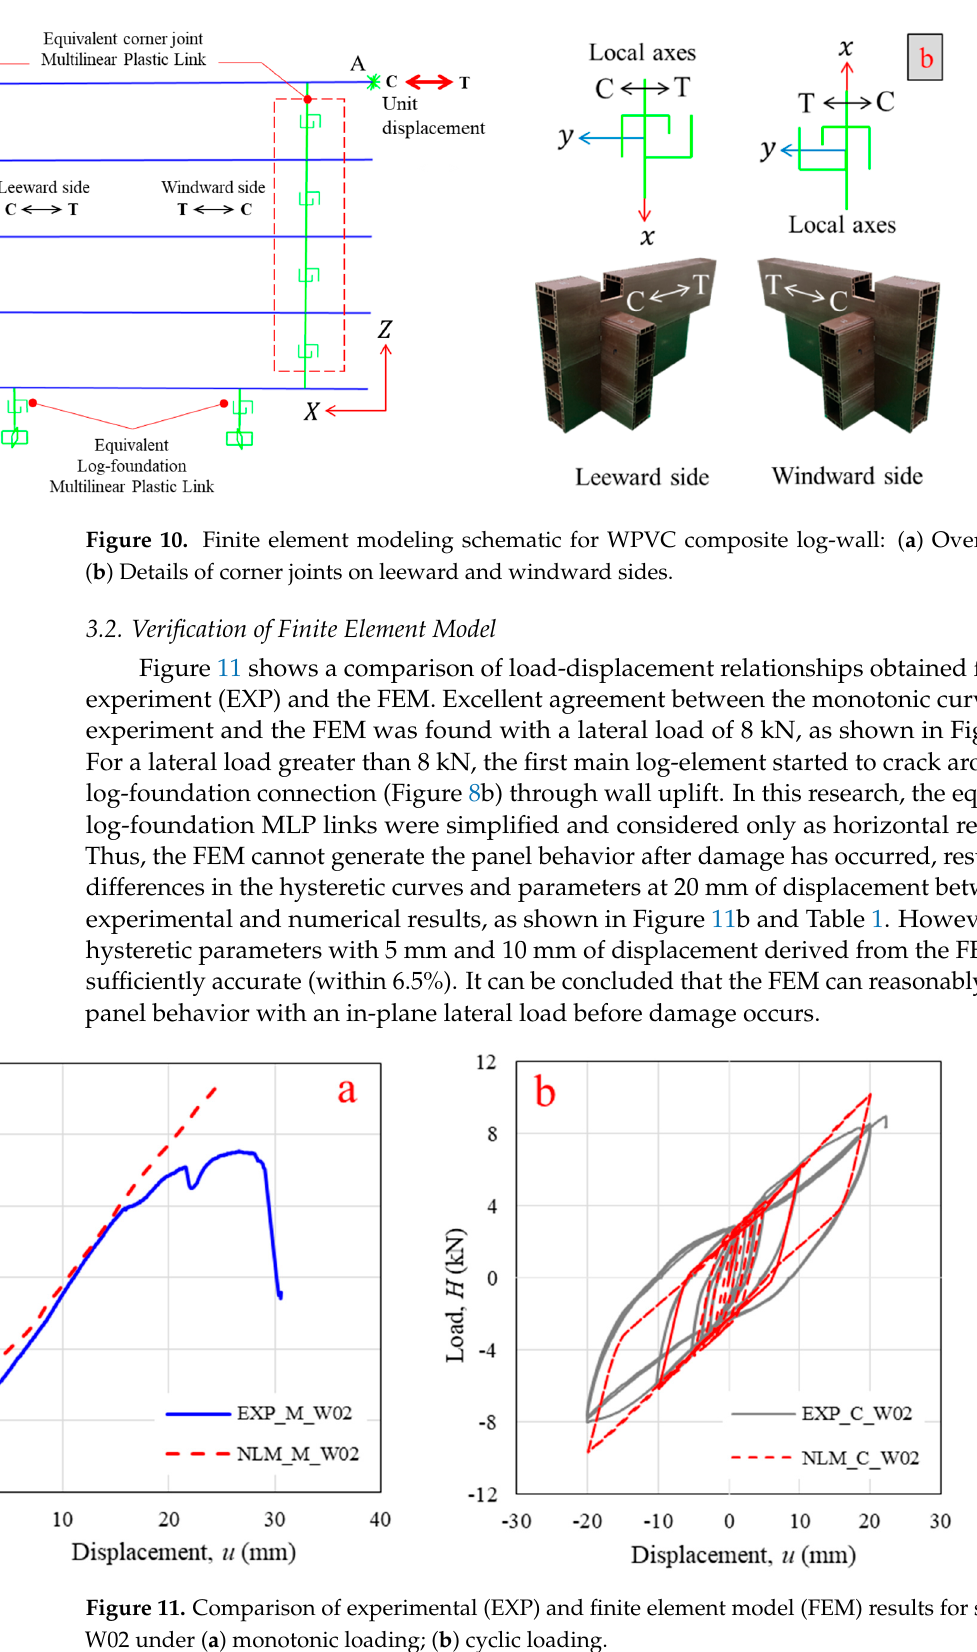
Figure 9. Nonlinear spring calibration with previous experiment for ( a ) Standard half-lapped corner